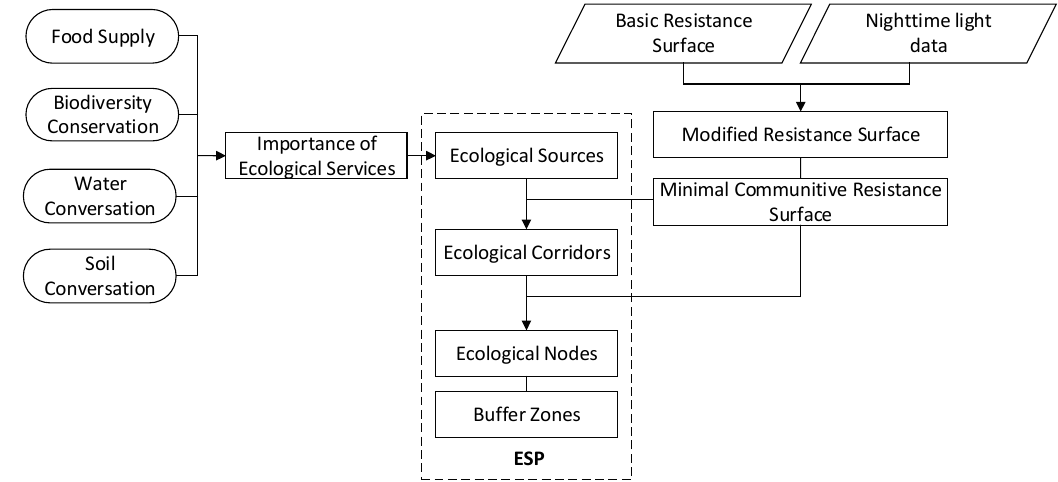
Figure 2. The methodology framework of the study.